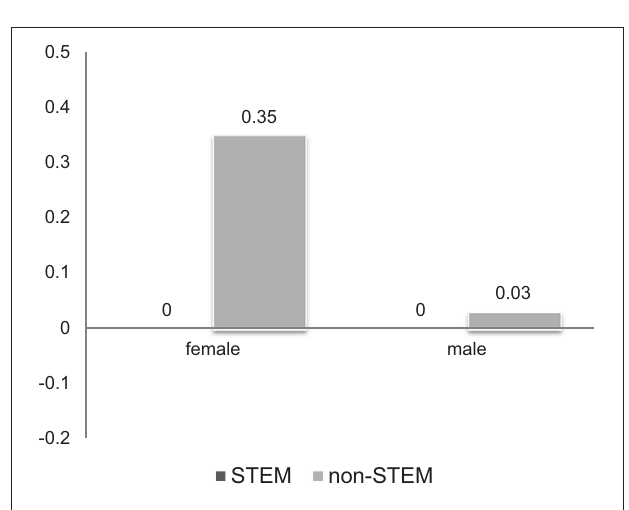
FIGURE 4 | Masculinity index of physics and career